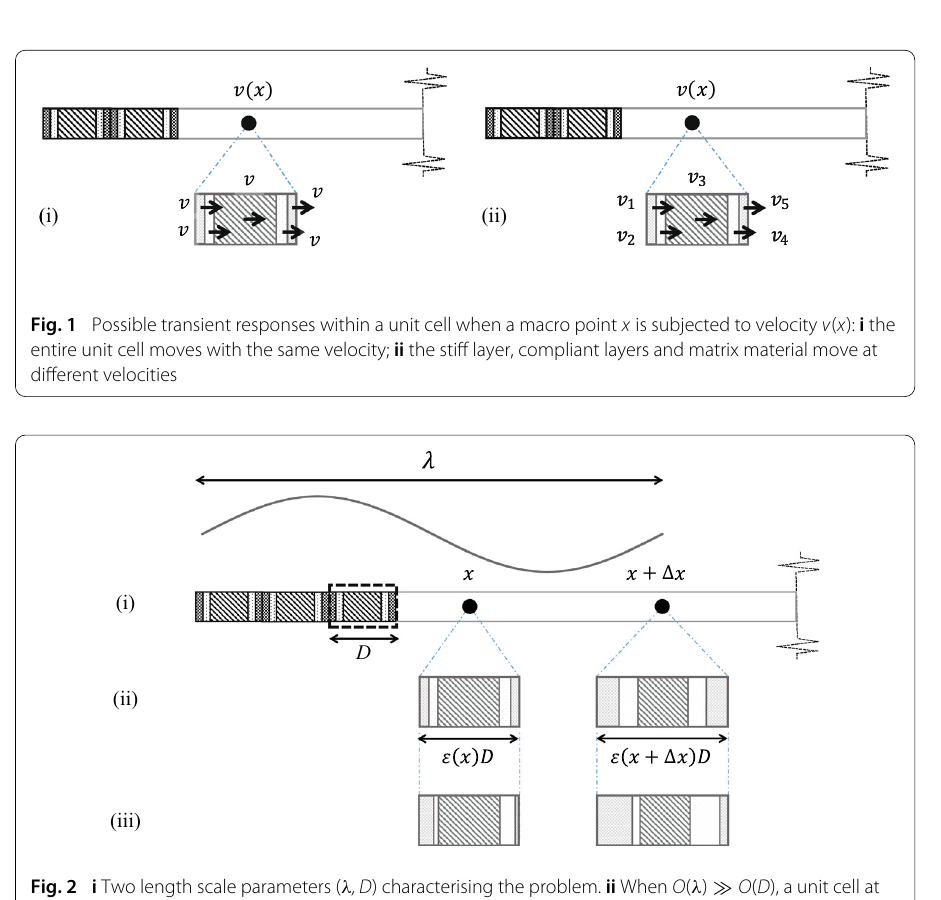
Fig. 2 i Two length scale parameters ( λ ,D ) characterising the problem. ii When O ( λ ) (cid:3) O ( D ), a unit cell at each macro point x deforms locally to satisfy the imposed macro strain. iii When O ( λ ) → O ( D ), the deformation within each unit cell is furthermore influenced by the short range forces from neighbouring